Question: Is the quantity shown trending increasing or decreasing?
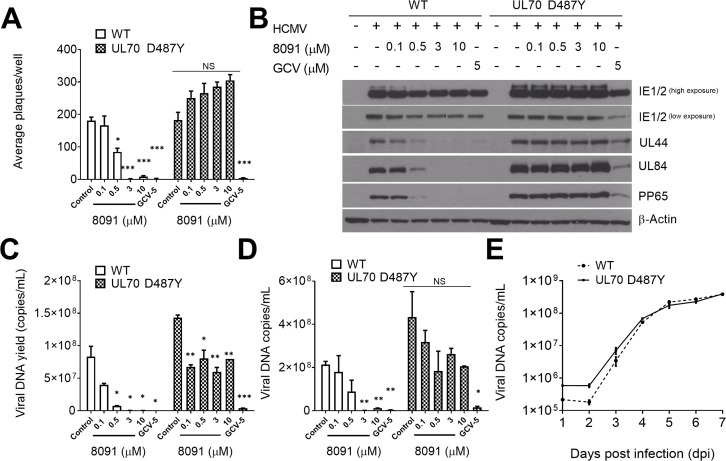
Answer: increasing